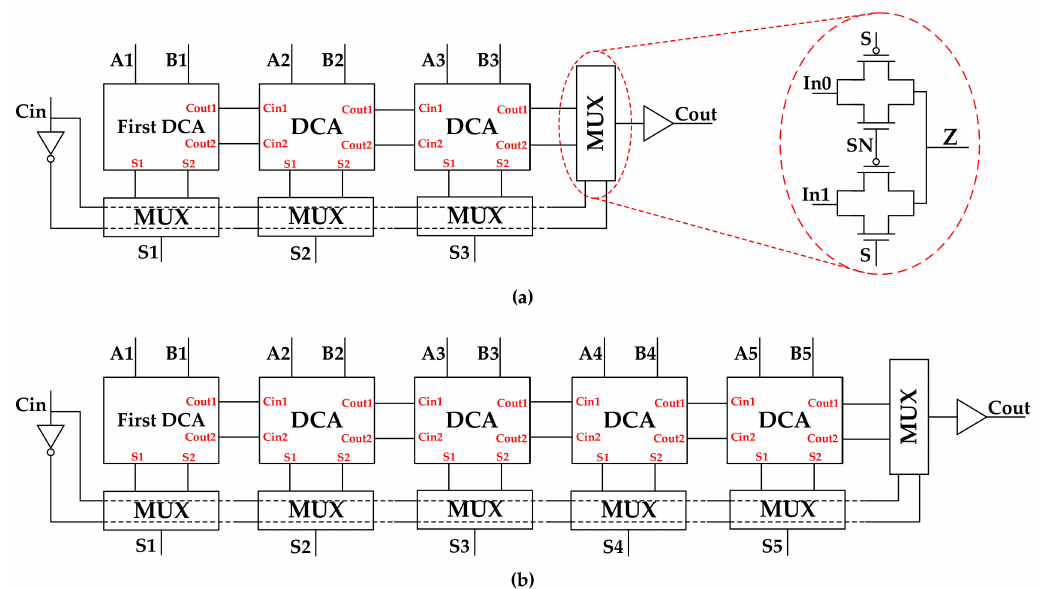
Figure 3. ( a ) Architecture of a 3 bit single-stage CSLA; ( b ) architecture of a 5 bit single-stage